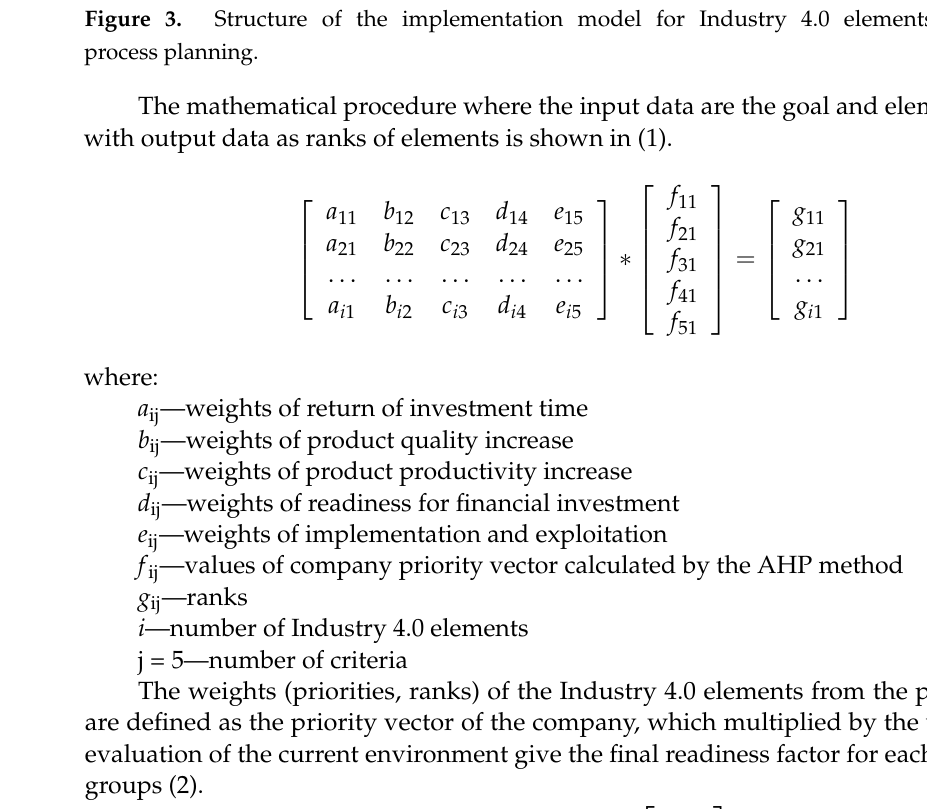
11 of 25 Figure 2. Priority matrix of the goals. The weights of the alternatives (Industry 4.0 elements) are defined by the expert group in the previous phase and calculated through the ranking method common in the Friedman test, while the ranks are calculated into the weights through the normalized